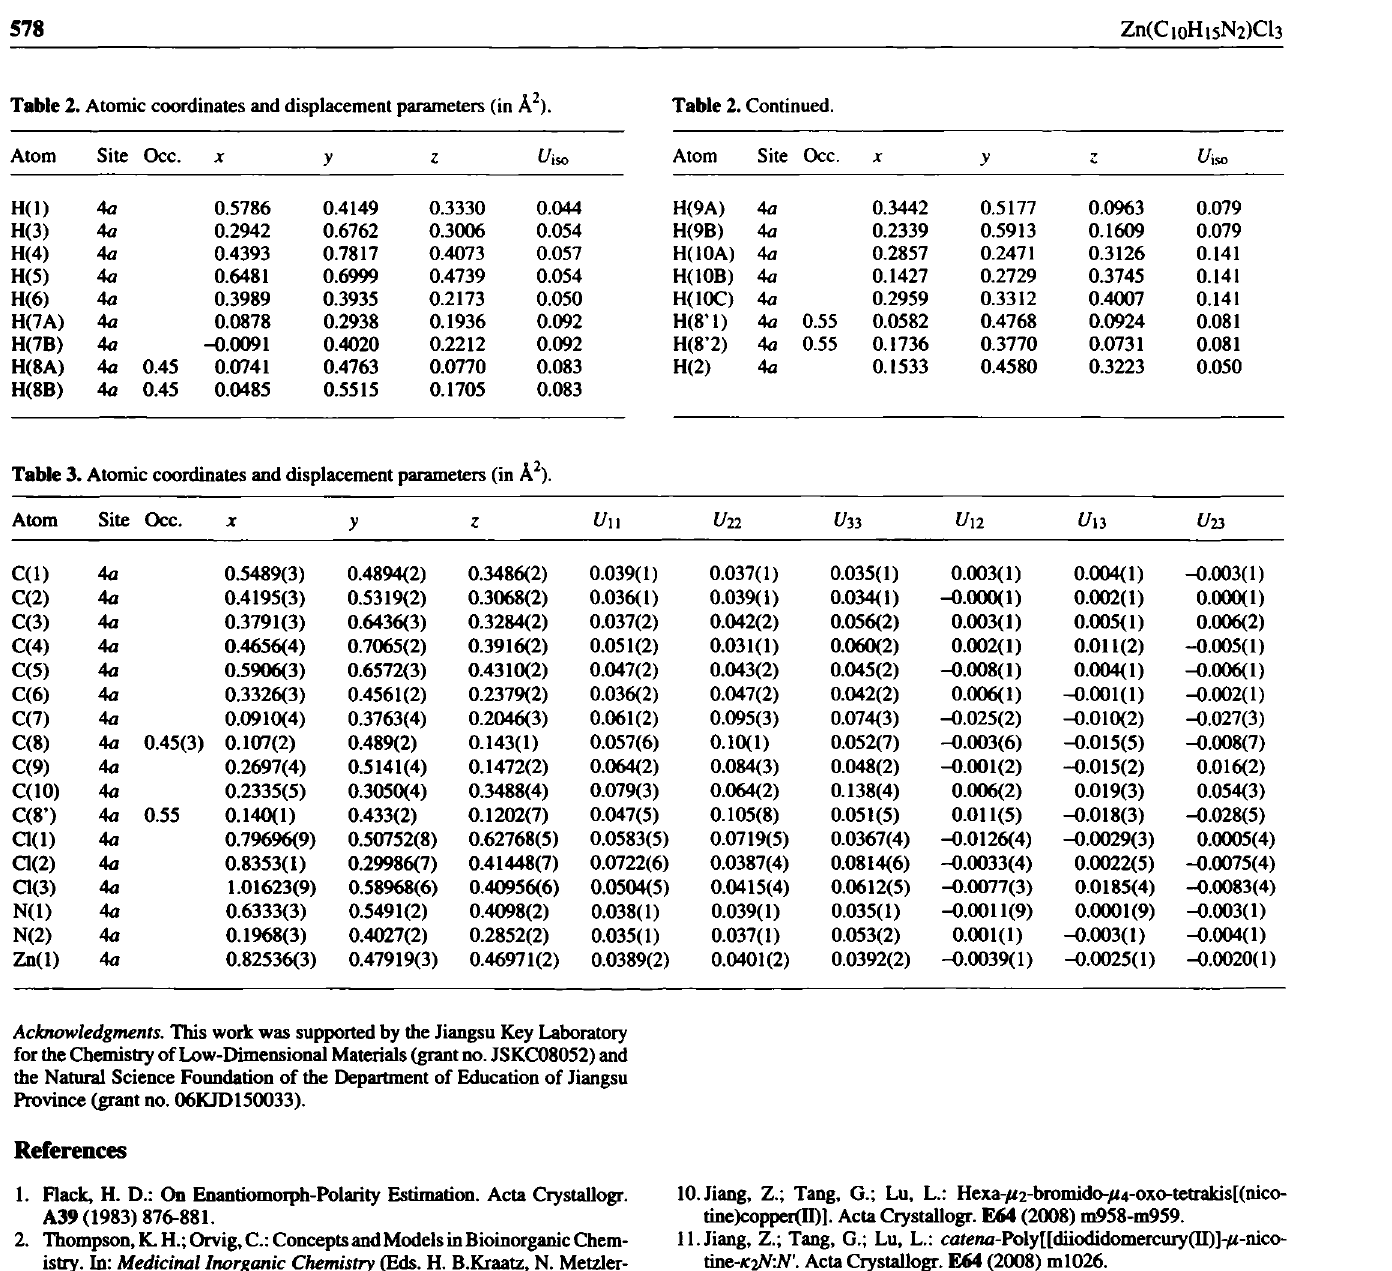
Table 2. Atomic coordinates and displacement parameters (in Ä 2 ).